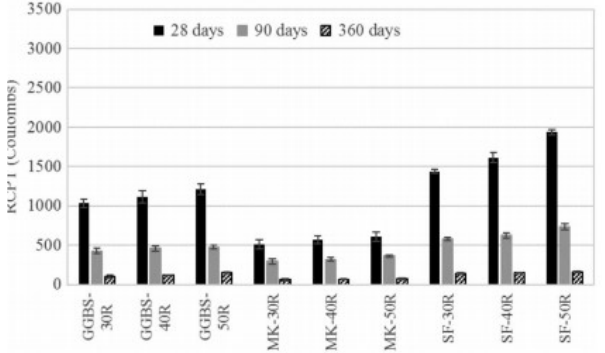
Figure 20. Effects of binary mineral admixtures on RCPT results. GGBS-30R FA+GGBS+30%Rubber content; MK-30R FA+MK+30%Rubber content; SF-30R SF+FA+30%Rubber content [17]. content; MK-30R FA + MK + 30%Rubber content; SF-30R SF + FA + 30%Rubber content